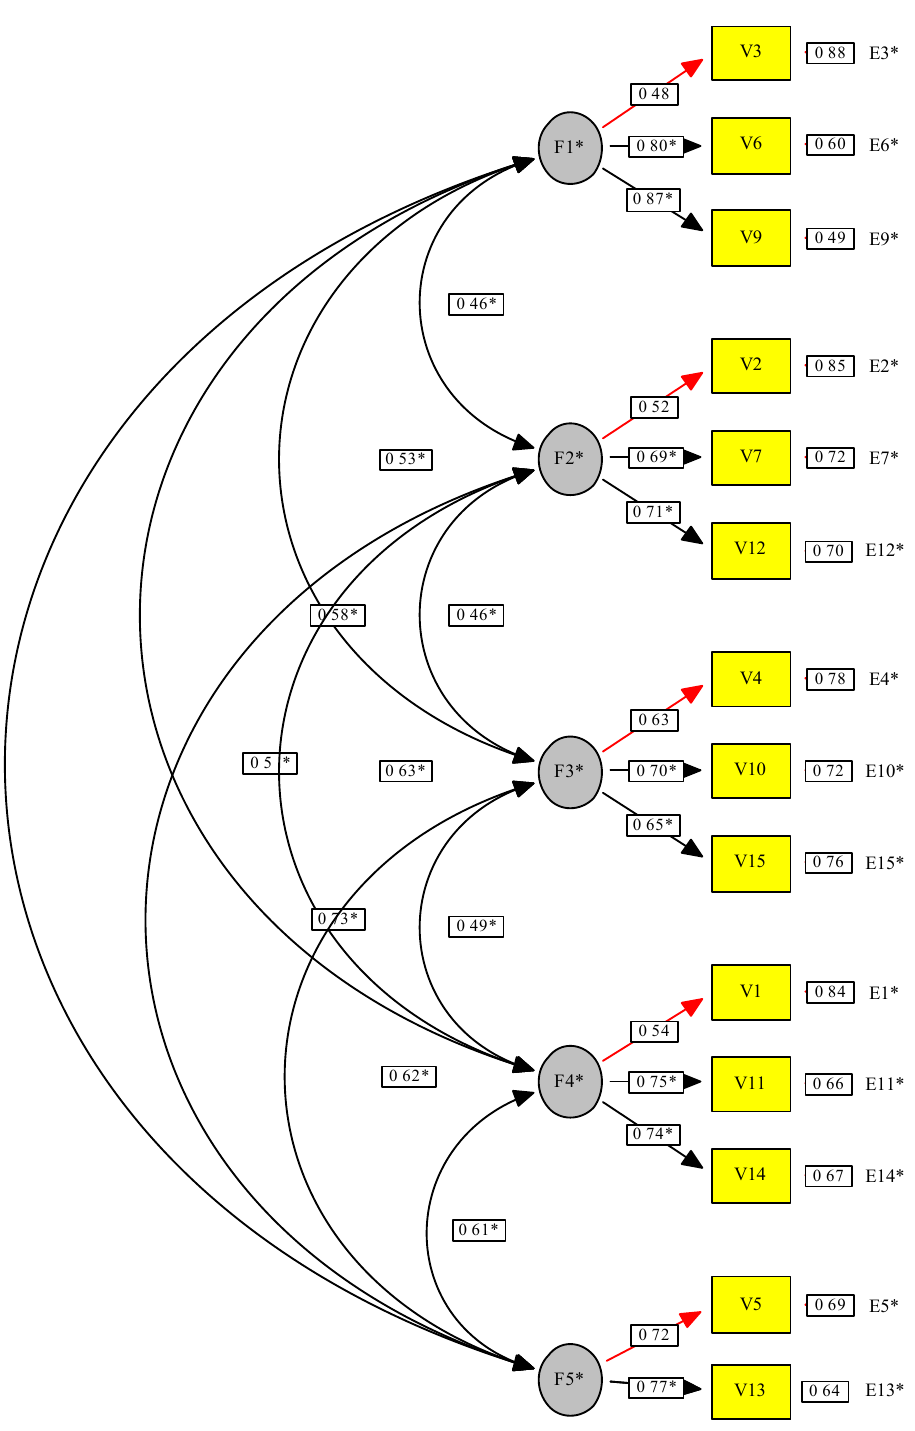
Figure 1 : Standardised estimated parameters of the revised